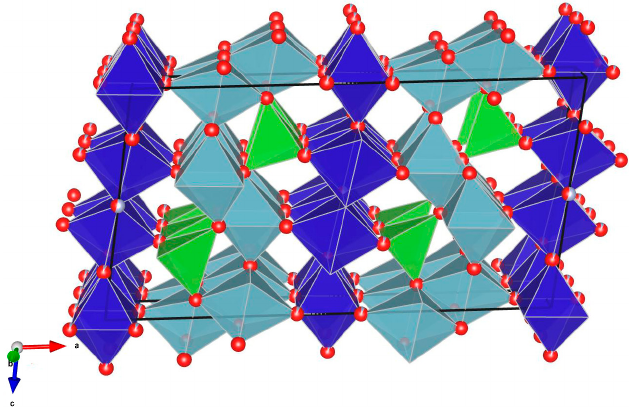
Figure 5. Structure of Ga-Ti-O-N, the gallium titanium oxynitride phase. Visualization is done by VESTA [29]. Deep blue polyhedra are occupied exclusively by Ti sites, green pure Ga and light blue are mixed Ti/Ga sites. Red balls represent anion sites occupied by oxygen; ON sites occupied mostly by nitrogen and by ~10% nitrogen, are represented by partially red and grey balls. The origin of the unit cell centered on Ti and is in the back top-left-hand corner, with z vertical, x to the right and y out of the page. The sites occupied by nitrogen are separated mostly into sites within blocks of Ti-centered octahedra, while oxide sites occupy mostly blocks occupied by Ga- and mixed TiGa sites.